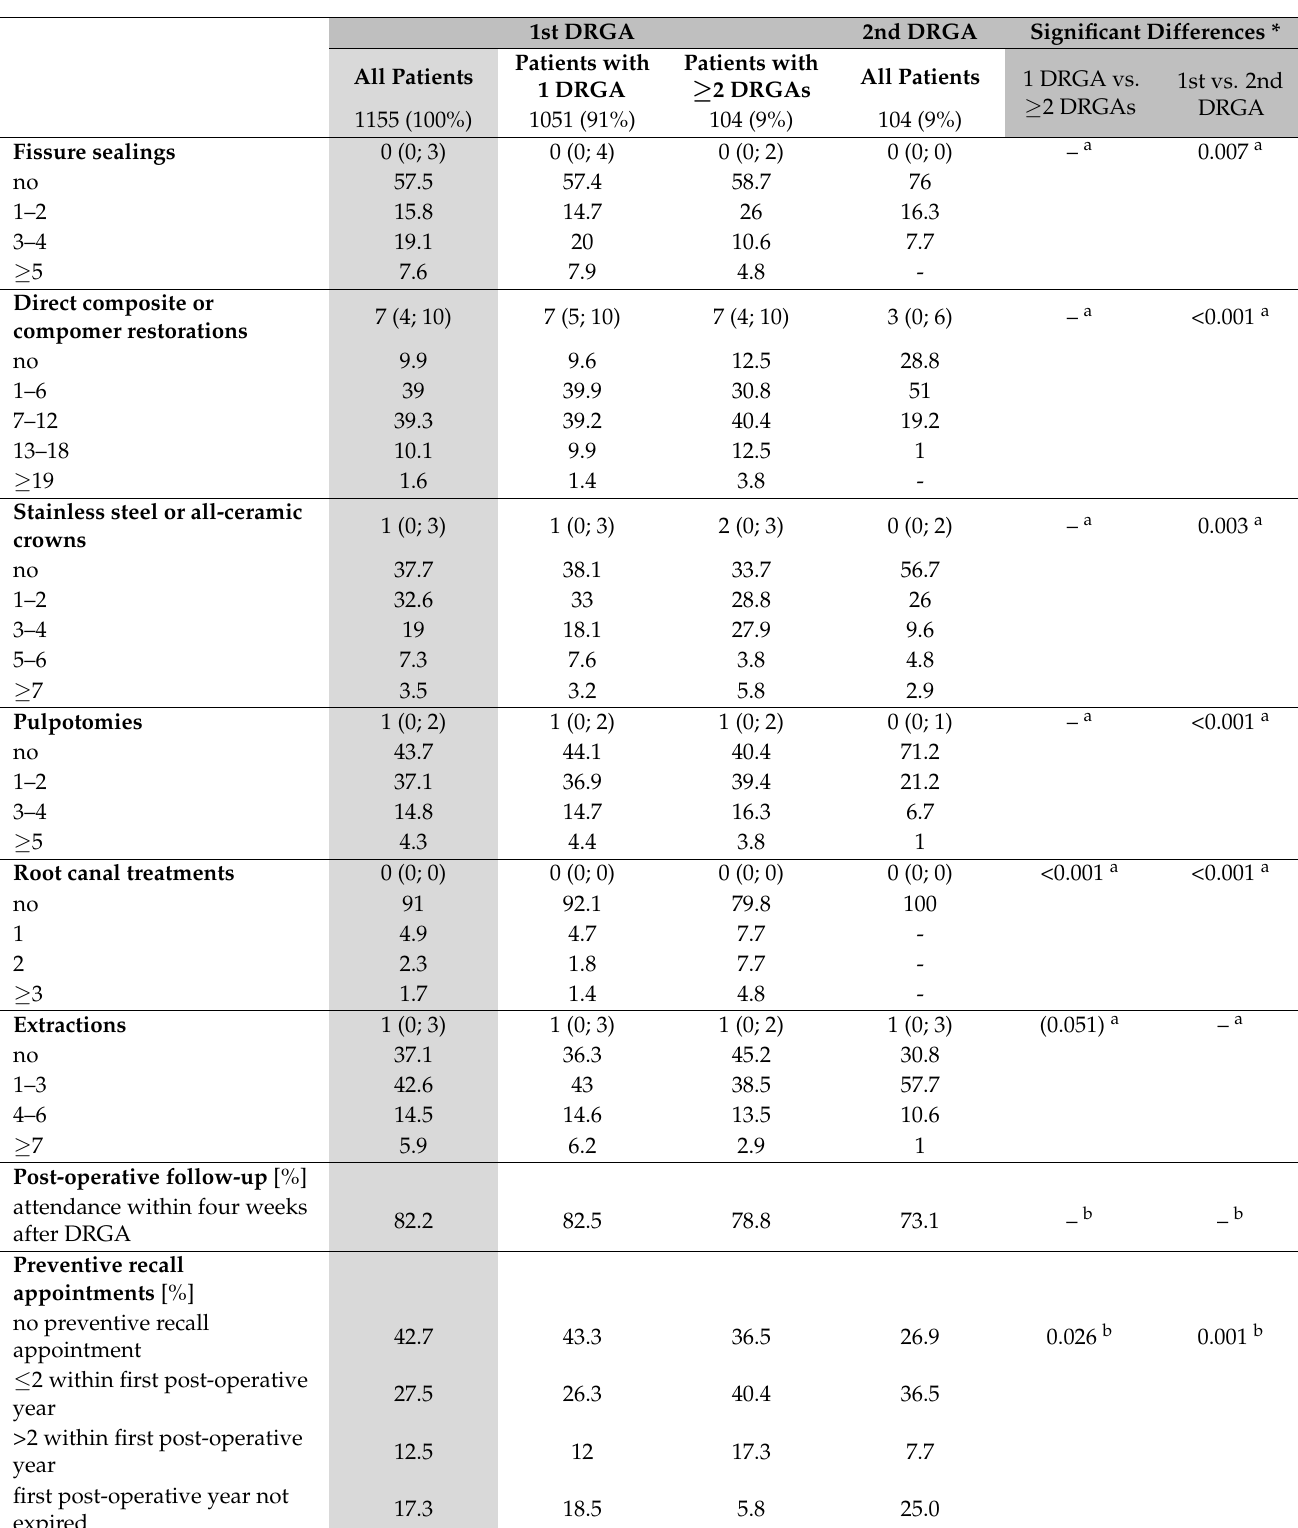
Table 3. Performed treatments in all patients during their DRGAs as well as attendance of post- operative recall. 1st DRGA 2nd DRGA Significant Differences * Patients with Patients All Patients 1 DRGA